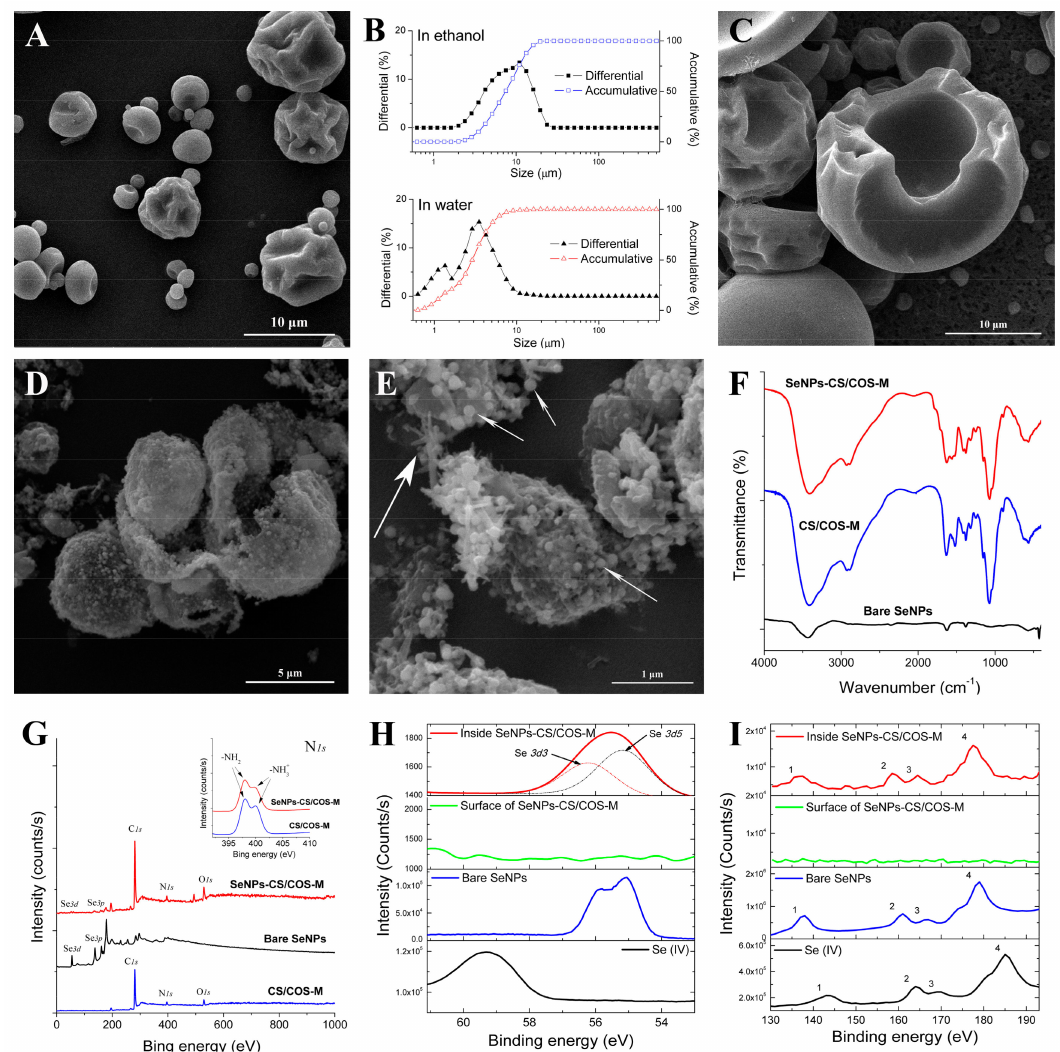
Figure 2. The typical morphology and chemical properties of selenium-nanoparticles-loaded chitosan / chitooligosaccharide microparticles (SeNPs-CS / COS-Ms). ( A ) An SEM image of SeNPs-CS / COS-Ms. ( B ) The size distribution of SeNPs-CS / COS-Ms in ethanol (upper) and in water (lower). ( C ) An SEM image of SeNPs-CS / COS-Ms after ultrasonic disruption in absolute ethanol. ( D – E ) SEM images of SeNPs-CS / COS-Ms at different magnifications, exactly ( D ) 16,000 × and ( E ) 50,000 × , after ultrasonic disruption in 50% ethanol. ( F ) FTIR spectra of bare SeNPs, CS / COS, and SeNPs-CS / COS-Ms. (G–I) XPS results, including ( G ) wide-range XPS patterns, ( H ) Se 3d scan XPS patterns composed of Se 3d3 and Se 3d5 signals, and ( I ) Se 3p scan XPS patterns. In Panel ( E ), smaller arrows indicate CS-SeNP nanobeads, while the bigger one represents the linear CS